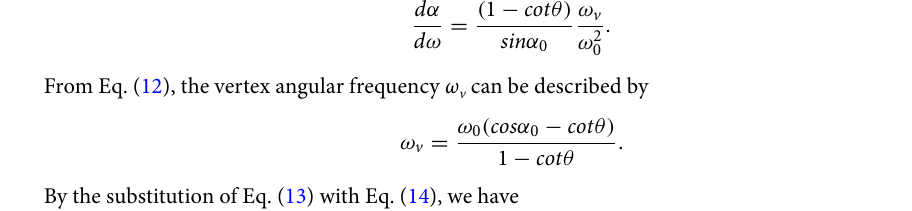
By the substitution of Eq. (13) with Eq. (14), we have